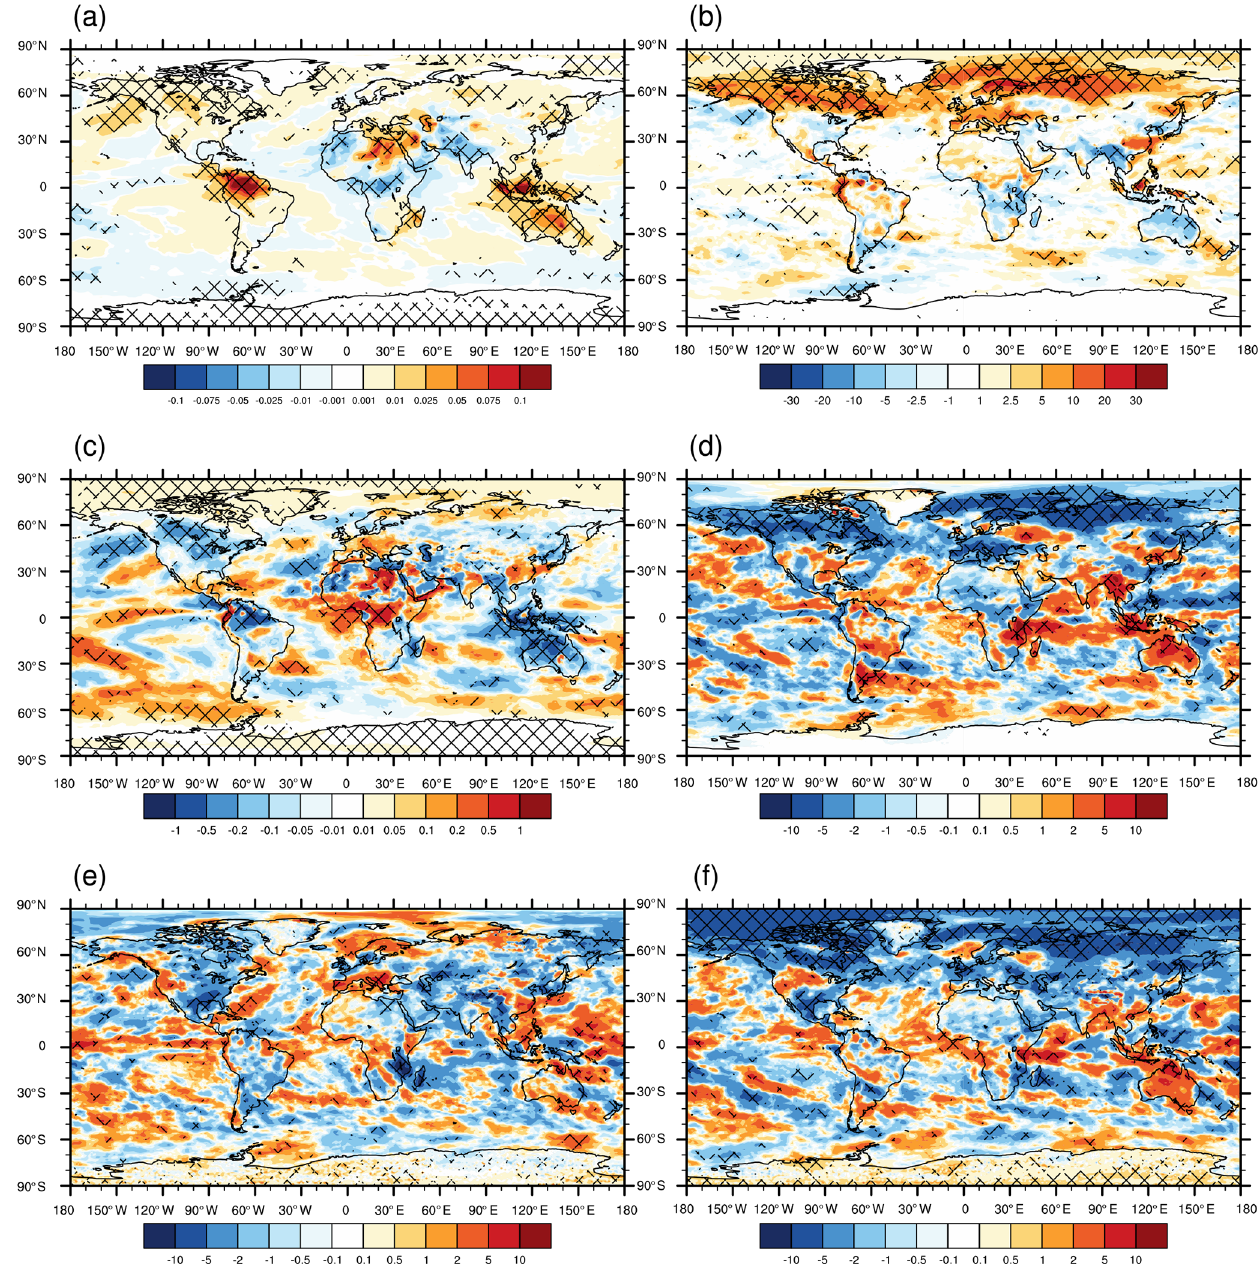
Figure 12. Changes in fire-induced weather conditions and climate radiative forcing between the RCP4.5 future scenario and the present- day scenario. (a) Changes in annual average column AOD at 550nm (unitless, (CTRL2–SENS2A)–(CTRL1–SENS1A)); (b) changes in cloud liquid water path (gm − 2 , (CTRL2–SENS2A)–(CTRL1–SENS1A)); (c) changes in RE ari , (Wm − 2 , (CTRL2–SENS2A)–(CTRL1– SENS1A)); (d) changes in RE aci (Wm − 2 , (CTRL2–SENS2A)–(CTRL1–SENS1A)); (e) changes in RE lcc (Wm − 2 , (SENS2A–SENS2B)– (SENS1A–SENS1B)); (f) changes in RE fire (Wm − 2 , (CTRL2–SENS2B)–(CTRL1–SENS1B)). The hatching denotes the 0.05 significance